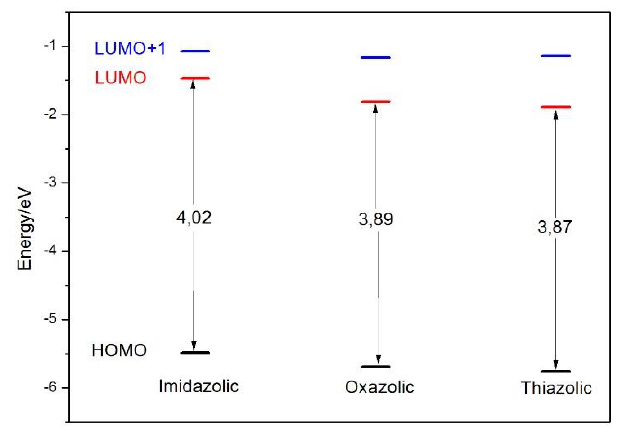
Figure 5. Representation of frontier orbital energy levels for N E , O E , and S E , respectively.